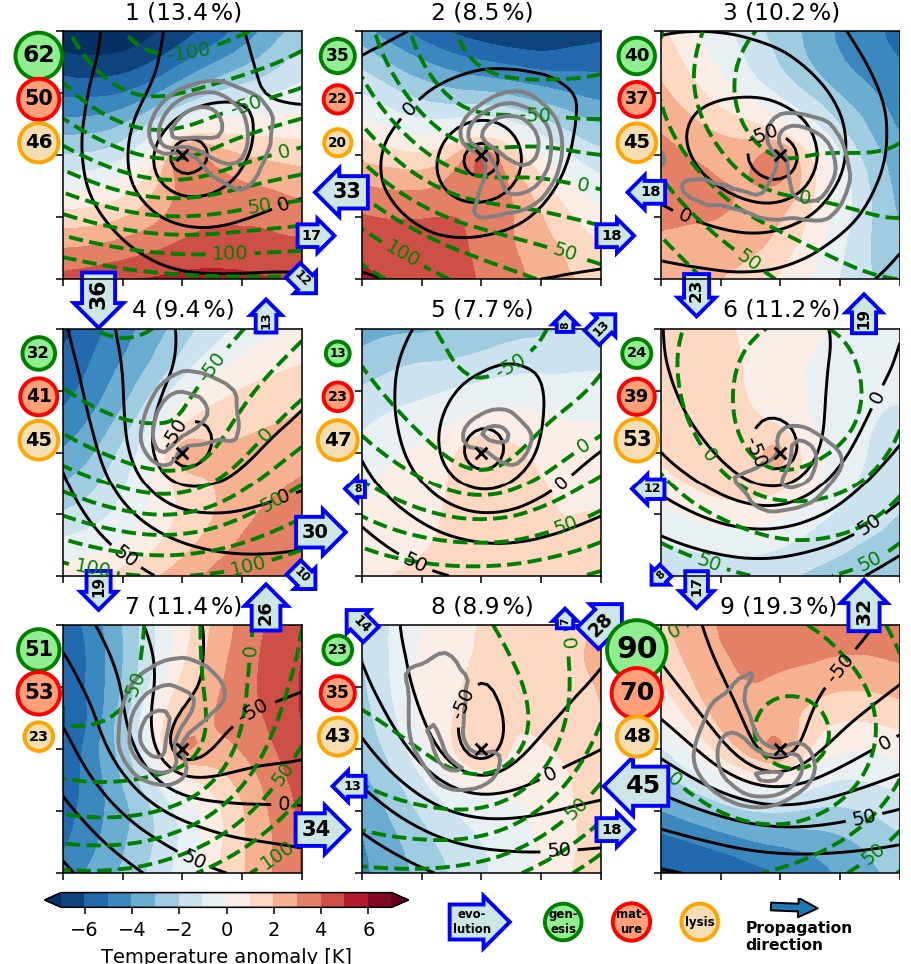
Figure 2. The self-organising map based on the 850hPa temperature anomaly ( T (cid:48) ) using 12695 PL time steps in a PL-centred grid as derived in Fig. 1. The black “x” marks the PL centre; ticks on the x and y axes are spaced at 250km. Displayed is the composite of the 850hPa temperature anomaly (shading), 1000hPa geopotential height anomaly (black contours, spacing 25m), 500hPa geopotential height anomaly (green dashed contours, spacing 25m), and medium-level cloud-cover fraction (grey contours at 0.7, 0.8, and 0.9). The number labels the SOM nodes and the percentage of time steps represented by the respective node. Green, red, and yellow circles indicate the number of genesis, mature, and lysis stages within each node. The numbers in the arrows indicate the amount of transitions between two nodes, where numbers smaller than 5 are not